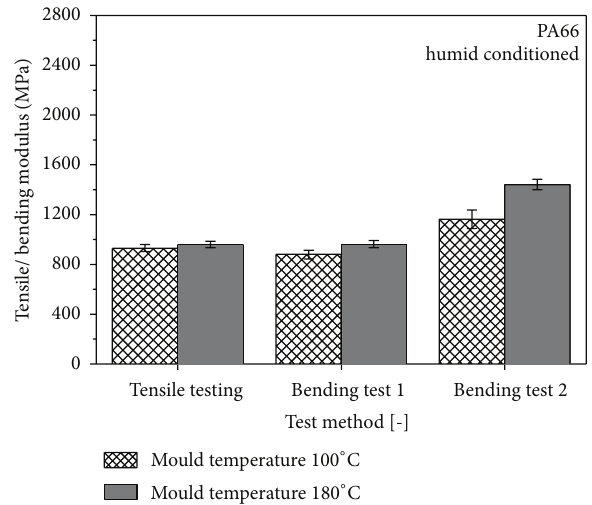
Figure 12: Tensile and bending modulus of the PA66 specimens, humid